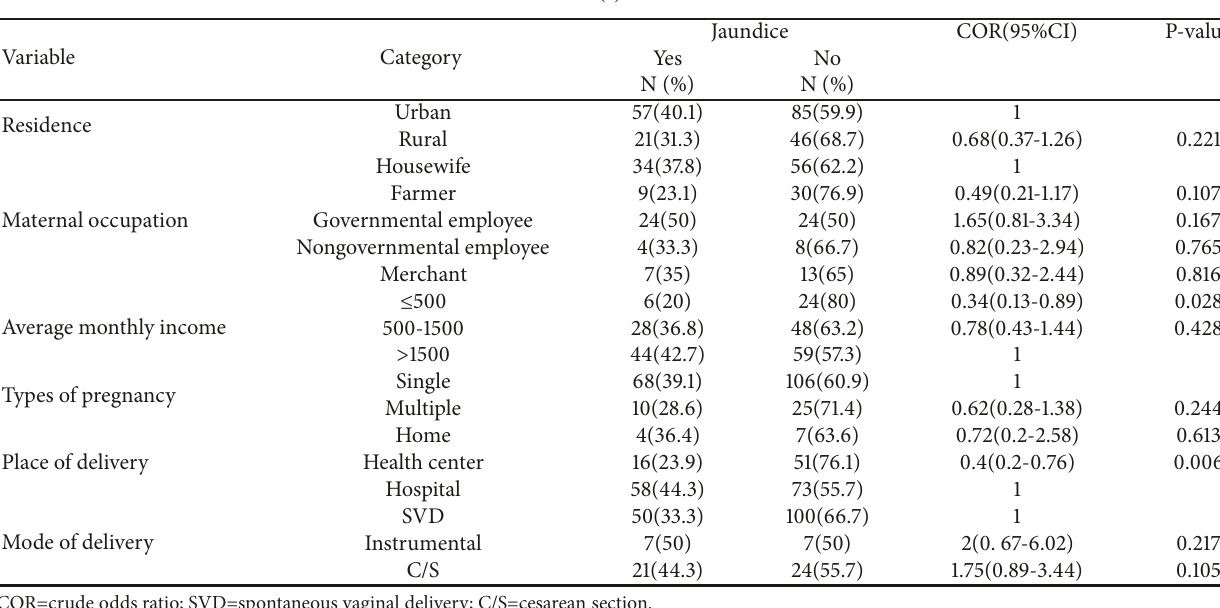
Table 3: Bivariate logistic regression analysis of different factors with neonatal jaundice among neonates admitted to NICU of Mekelle city public hospitals, Northern Ethiopia,